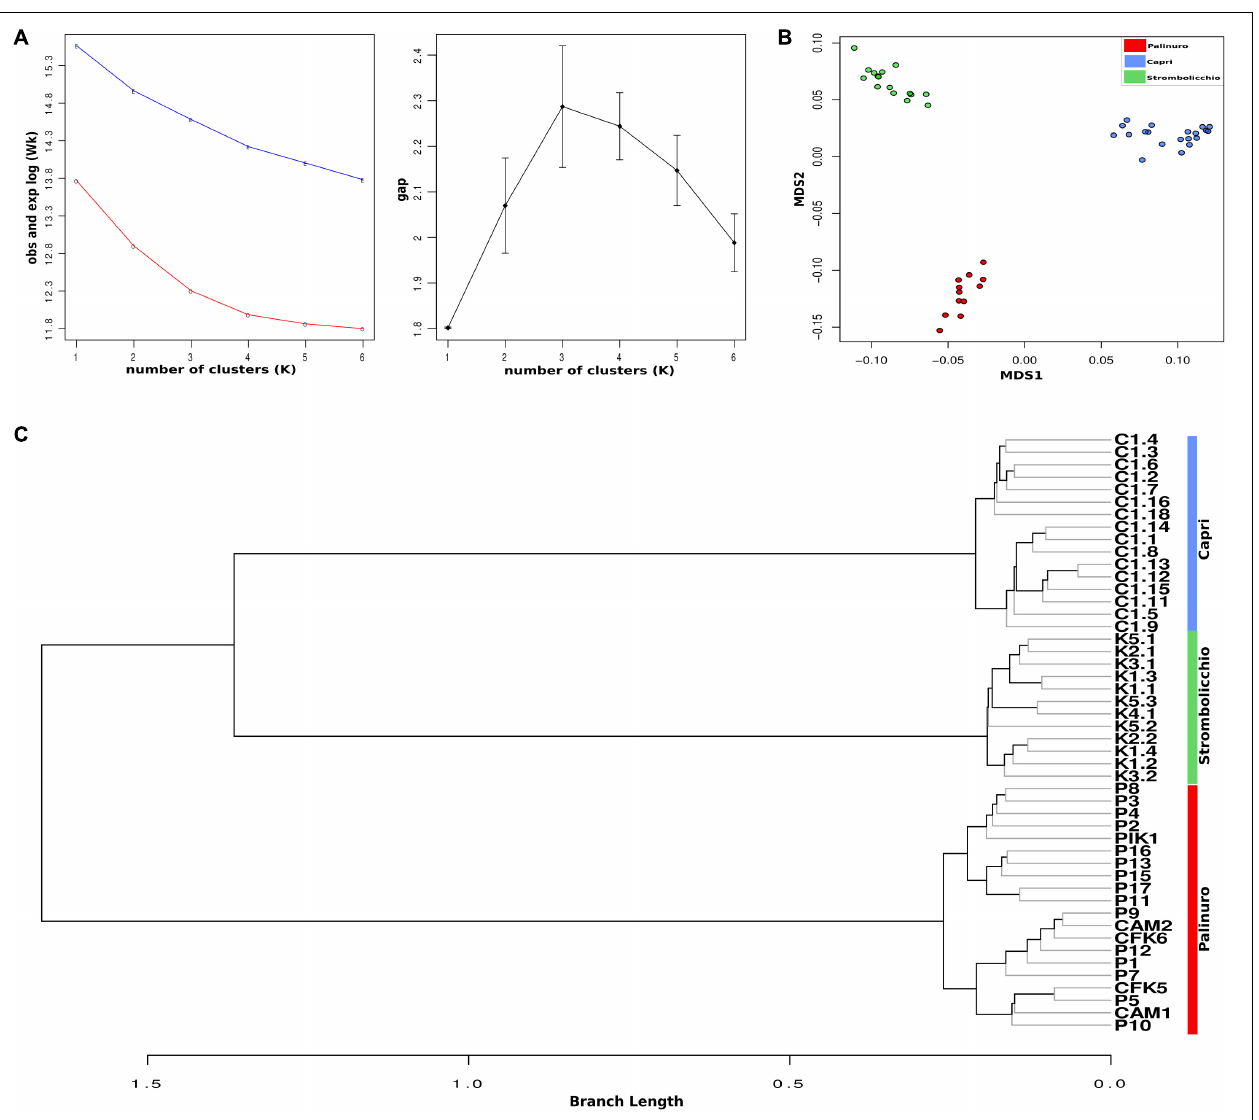
FIGURE 2 | Genetic clustering of sampled individuals. (A) Left: The red line represents the log of the pooled within-cluster sum of squares (Wk) from the observed data. The blue line represents the expected log of Wk from a uniform distribution. Right: the actual gap statistic. (B) A clustering by size reduction (an MDS plot) is represented. Individuals are distributed as points in a two-dimensional vector space. (C) The ancestry-inferred tree with